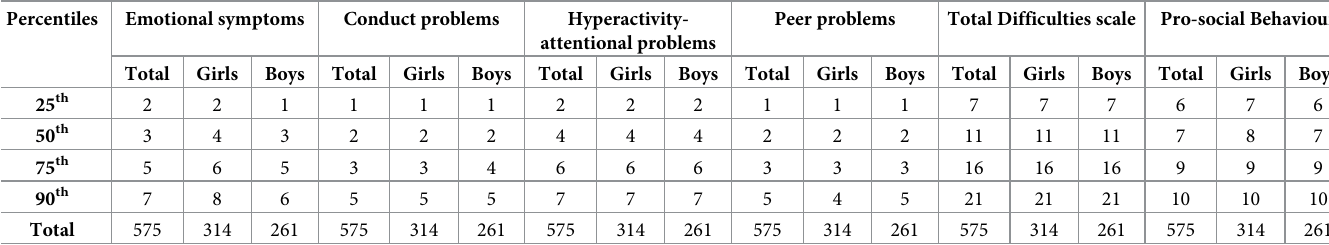
Table 9. Normative data for total scores by sex based on adolescent self-report, age group 12–15. Percentiles